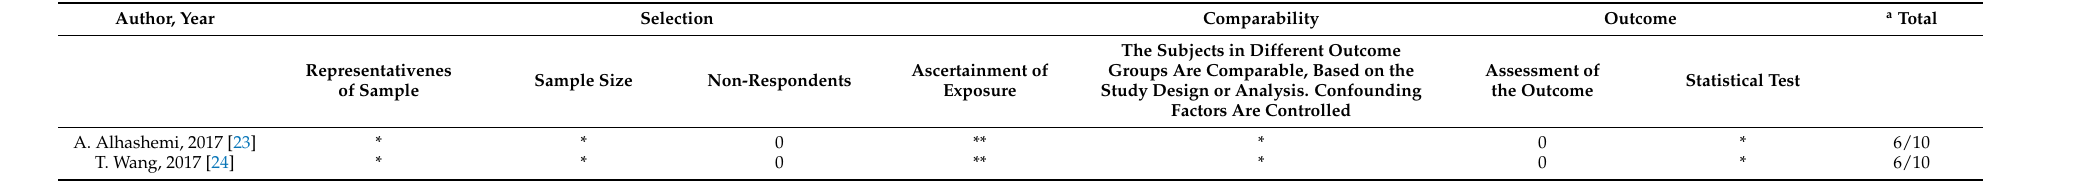
Table 3. Qualitative evaluation of cross-sectional studies according to Newcastle-Ottawa